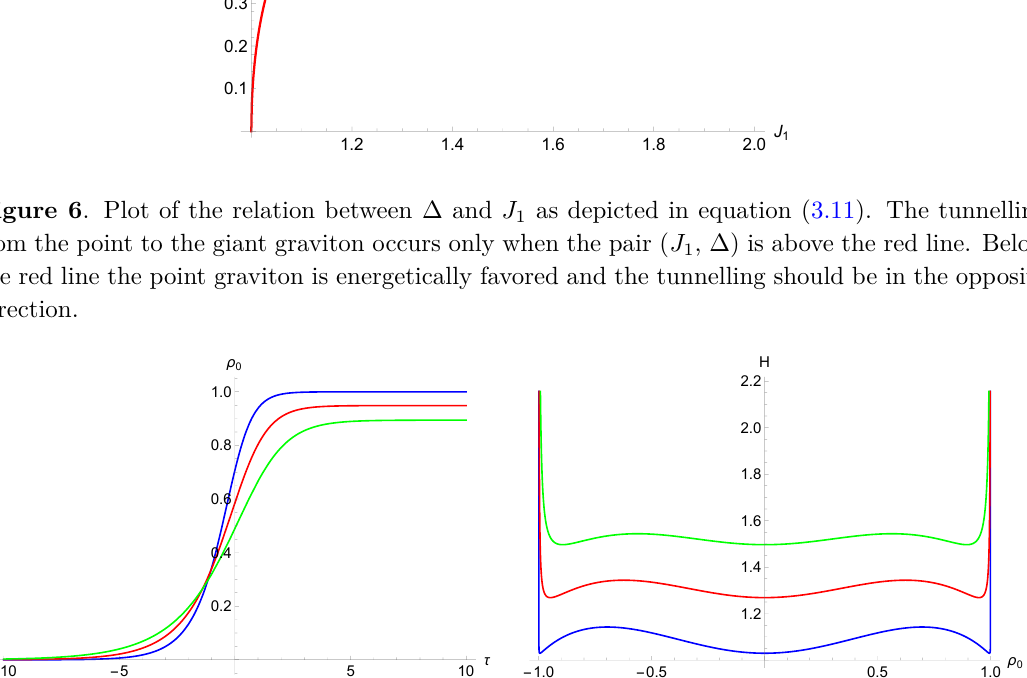
Figure 7 . Left plot: instanton solution in the specific case that W = 0 in which the two graviton solutions are degenerate. The plot is for 3 different values of J instanton solutions of the left plot. It is clear that when W = 0 the energies of the point and giant gravitons are equal. The correspondence between colors and values of J Red ⇒ J = 1 . 1 & Green ⇒ J = 1 . 1 1